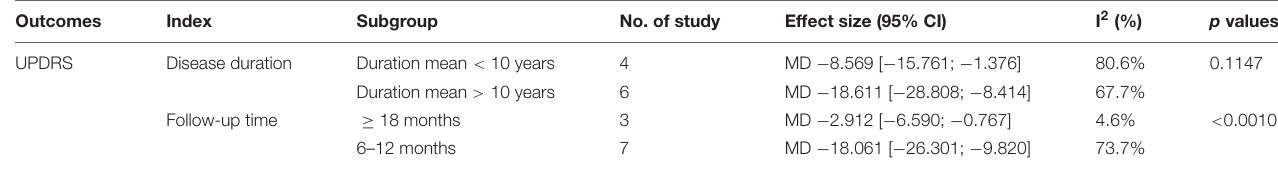
FIGURE 3 | Forest plots of the efficiency of the comparisons before and after cell transplantation. [ (A) Forest plot for primary outcome analysis on motor function by the Unified Parkinson’s Disease Rating Scale (UPDRS) III. (B) Forest plot for Sensitivity analysis of the primary outcomes. (C) Forest plot for secondary outcome analysis on daily living ability by the Unified Parkinson’s Disease Rating Scale (UPDRS) II.] TABLE 2 | Characteristics of the subgroup analysis of comparisons Before and after cell transplantation according to duration mean and follow-up